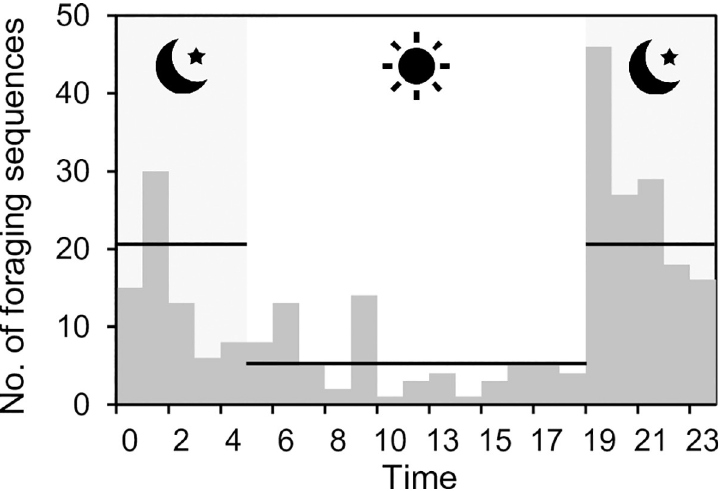
Fig 6. Diel pattern of harbour porpoise foraging sequences around the bottom-gillnet recorded in the present study. Horizontal lines indicate mean number of foraging sequences hour -1 , for night-time (20.8 ± 3.8, mean ± S.E.) and daytime (5.2 ±